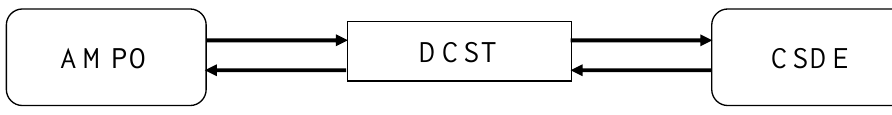
Figure 2. The Architecture of the Proposed HYPO Framework.